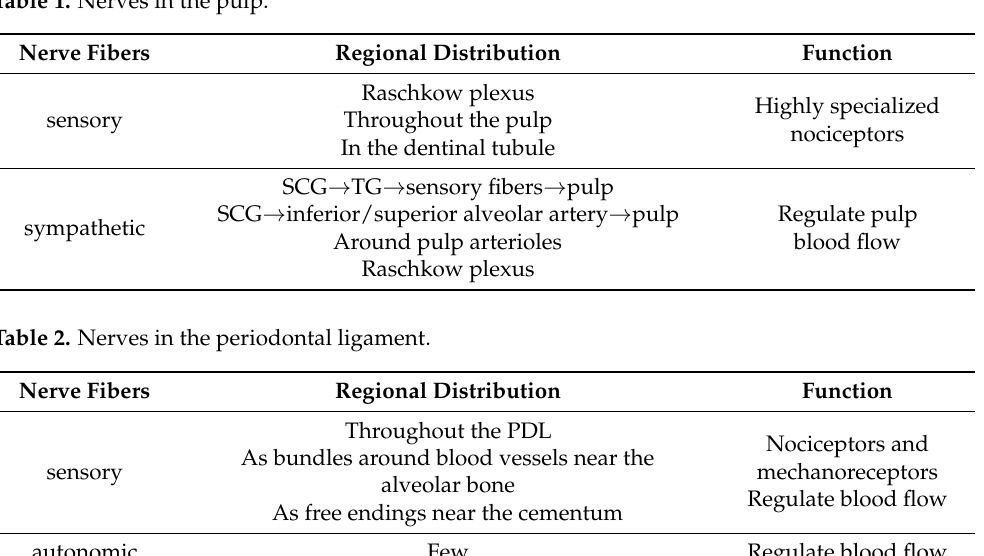
Table 1. Nerves in the pulp.